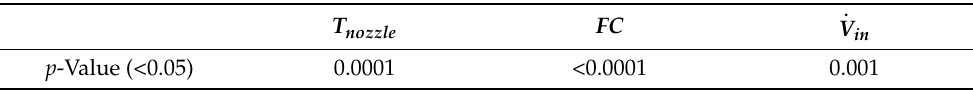
Figure 10. ( a ) Injection pressure of wood ‐ filled TPU as a function of injection volume flow and temperature control. ( b ) Injection pressure of wood ‐ filled TPU as a function of fiber content and injection volume flow. Table 7. p ‐ values of various test parameters for strain.